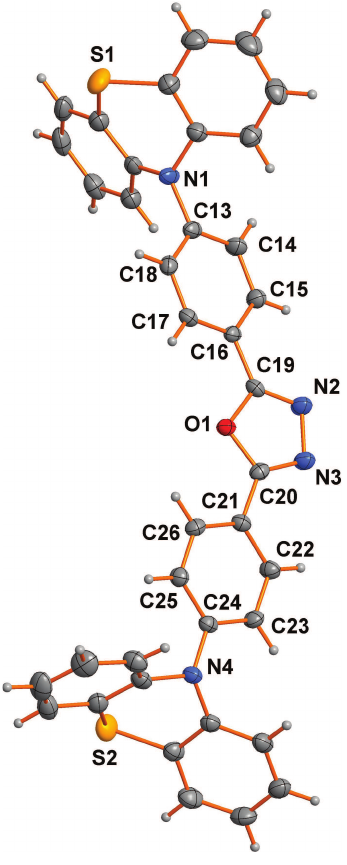
Table 2: Fractional atomic coordinates and isotropic or equivalent isotropic displacement parameters (Å 2